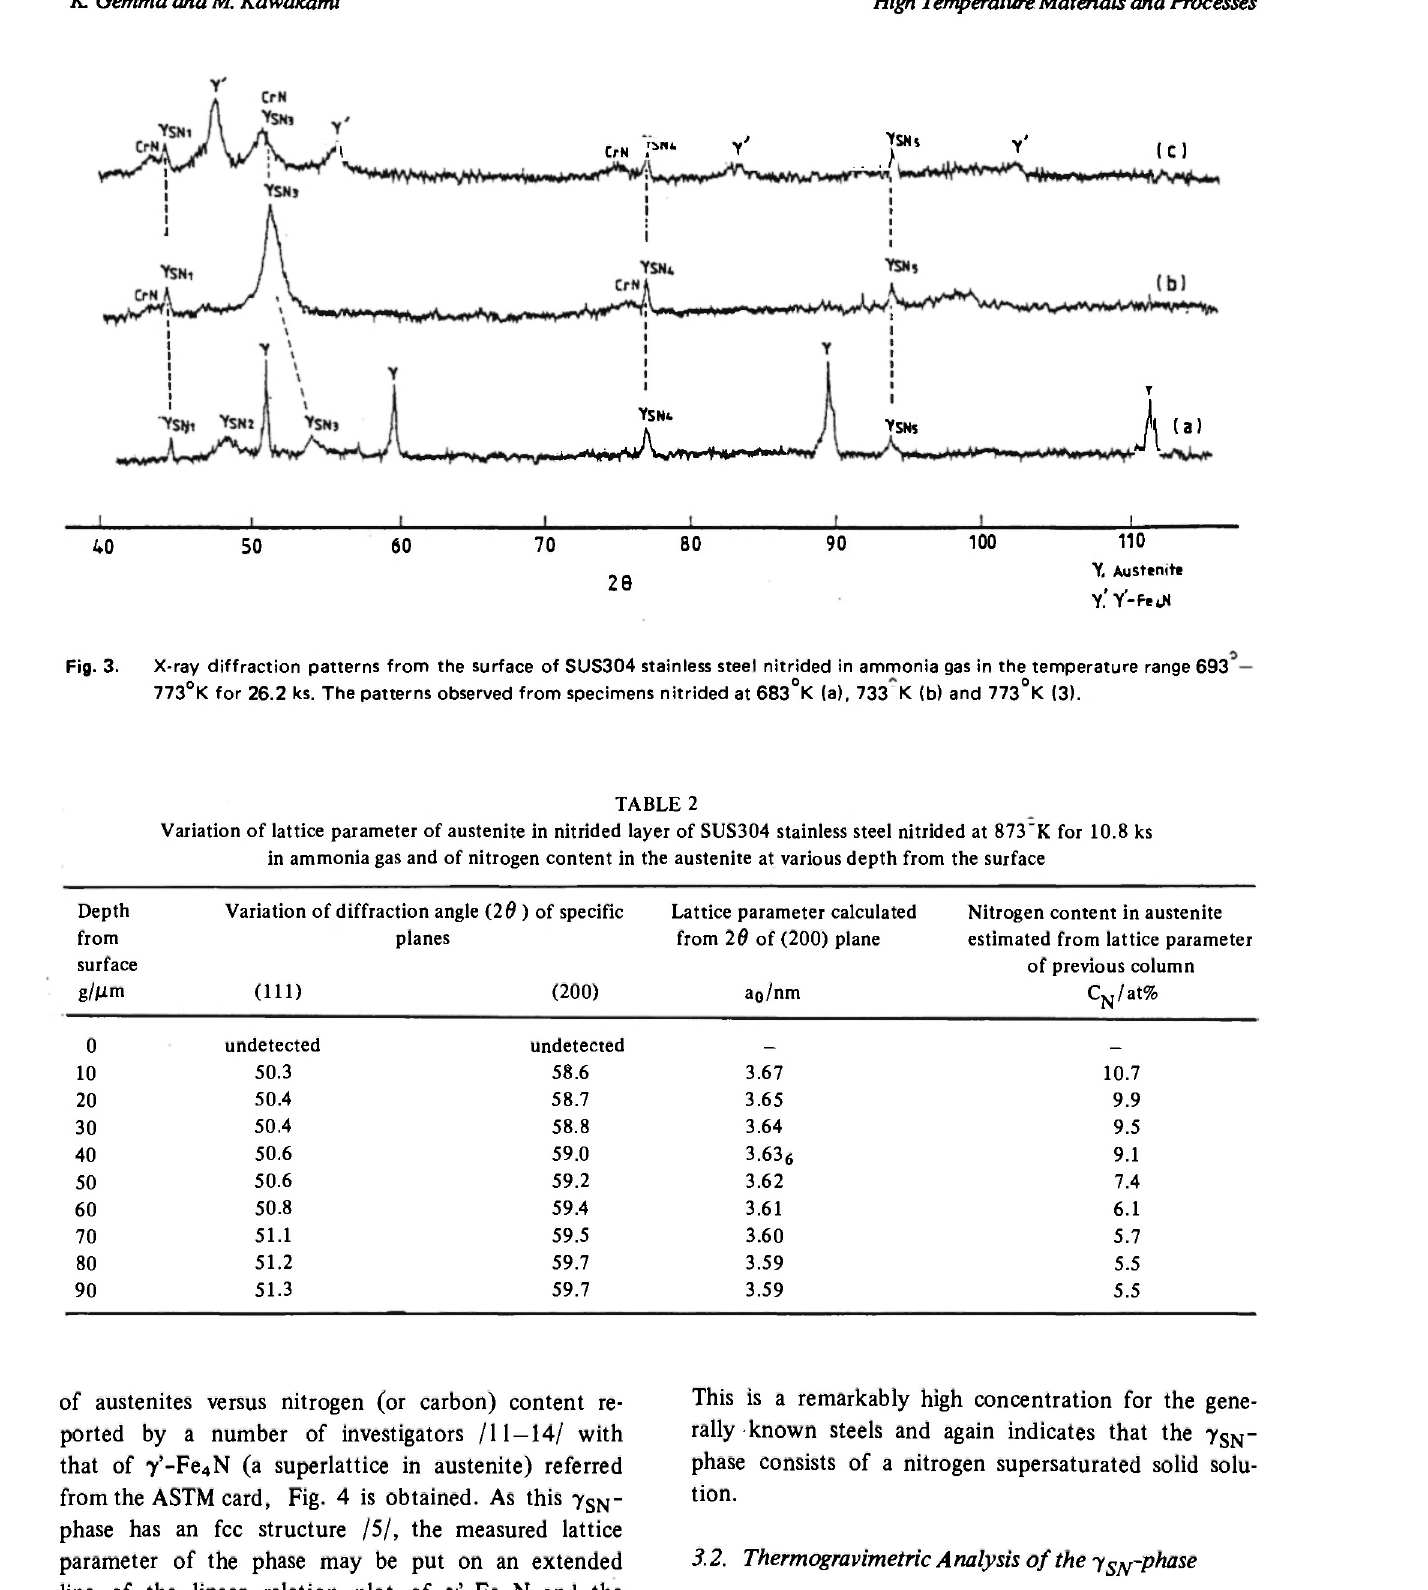
This is a remarkably high concentration for the gene- rally known steels and again indicates that the γ 5 Ν - phase consists of a nitrogen supersaturated solid solu-